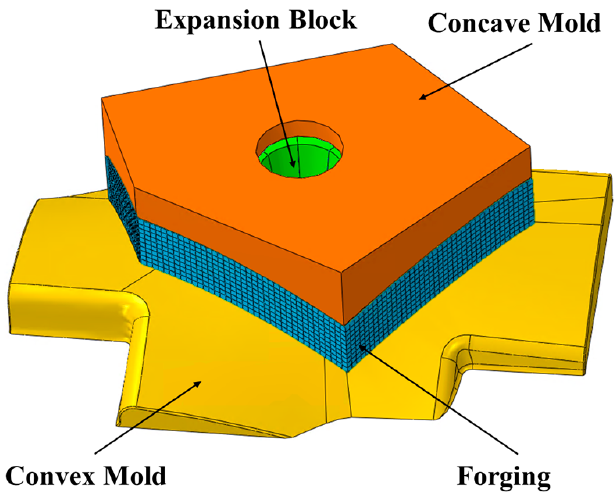
Figure 4. Simulation model of cold expansion.